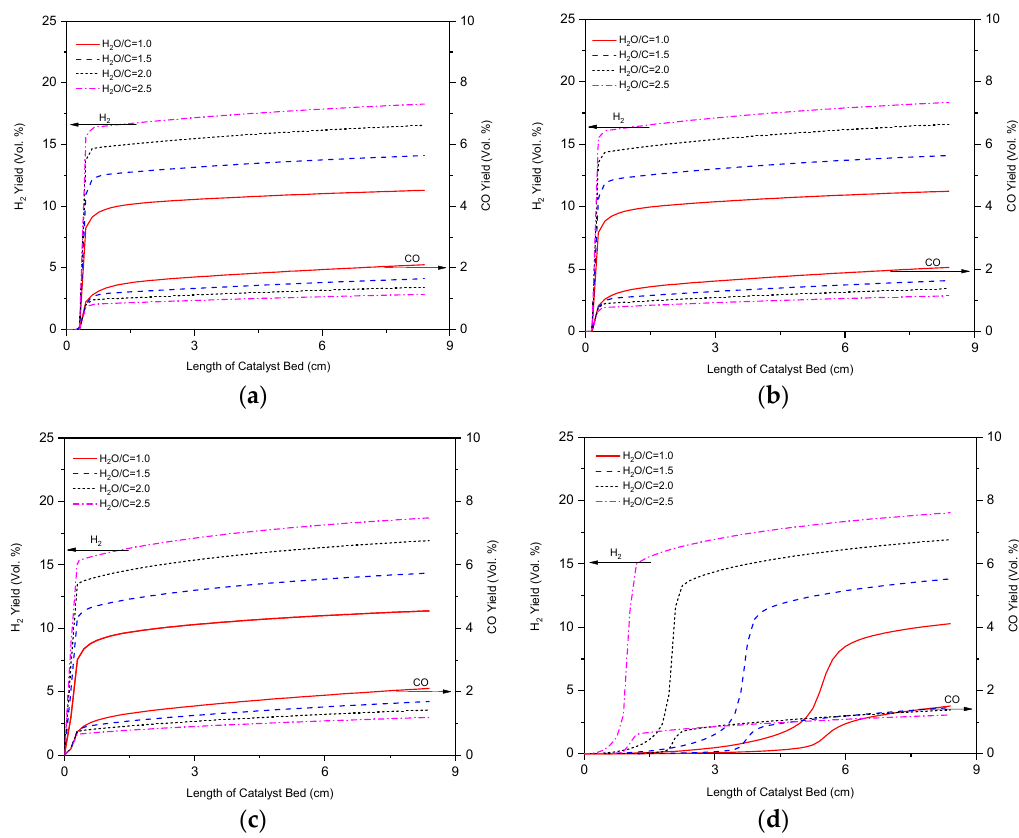
Figure 5. H 2 O/C ratio conditions: 1.0, 1.5, 2.0 and 2.5 at different reaction temperatures: ( a ) 400 °C; ( b ) 450 °C; ( c ) 500 °C; ( d ) 550 °C.